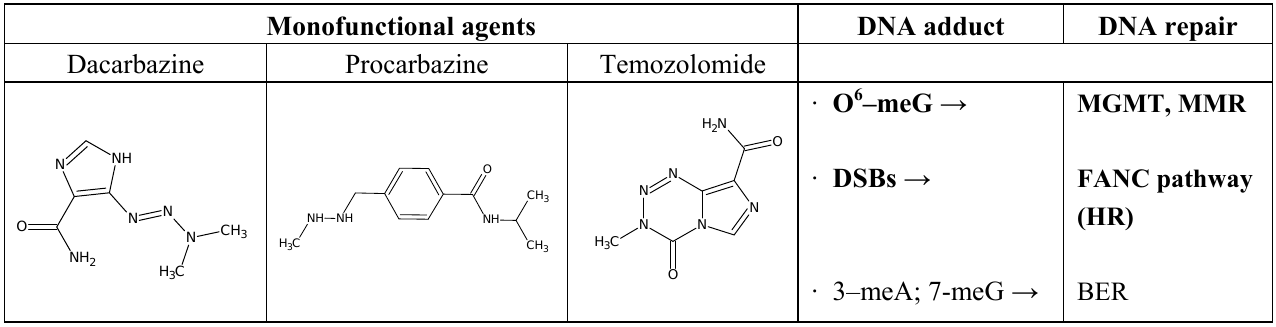
Table 1. Major monofunctional alkylating agents associated with the risk of occurrence of